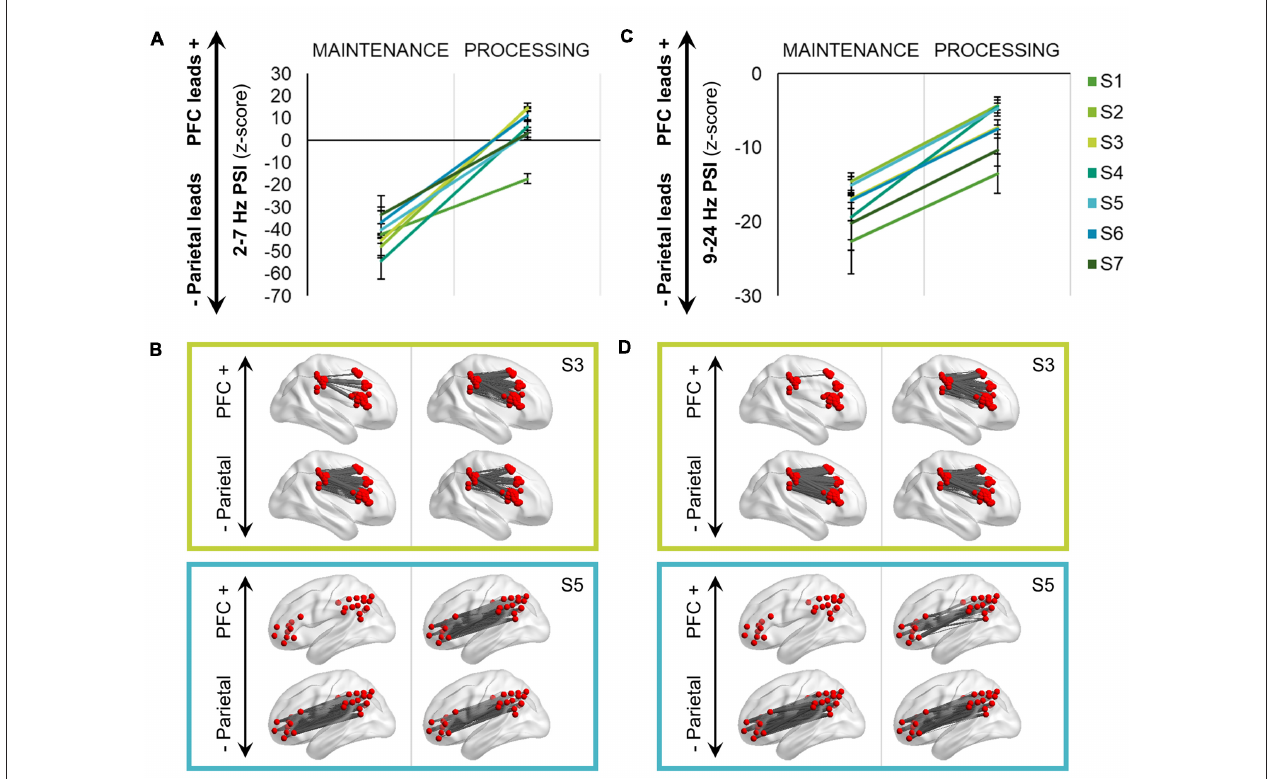
FIGURE 4 | Bidirectional frontoparietal oscillations for information processing. (A) Delta-theta (2–7 Hz) phase slope index (PSI) shifted from a unidirectional, parietal-led network during maintenance to a bidirectional, frontoparietal network during the processing interval ( p < 8 × 10 − 306 ). Data are represented as mean ± SEM per subject across all trials; positive values indicate that the prefrontal cortex (PFC) leads the parietal cortex and negative values indicate that the parietal cortex leads the PFC. S, subject. (B) Topographical representations of the PSI data depicted in (A) in two subjects. PSI is masked per electrode pair, with significant PFC leads in the top row ( z > 1.96, p < 0.05) and parietal leads ( z < − 1.96, p < 0.05) in the bottom row. S3 was implanted subdurally in the right hemisphere and S5 in the left hemisphere. (C) Equivalent to (A) : alpha-beta (9–24 Hz) PSI shifted from a unidirectional, parietal-led network during maintenance to a bidirectional, but still net parietal-led network during the processing interval ( p = 0). (D) Equivalent to (B) : topographical representations of the PSI data depicted in (C) in two